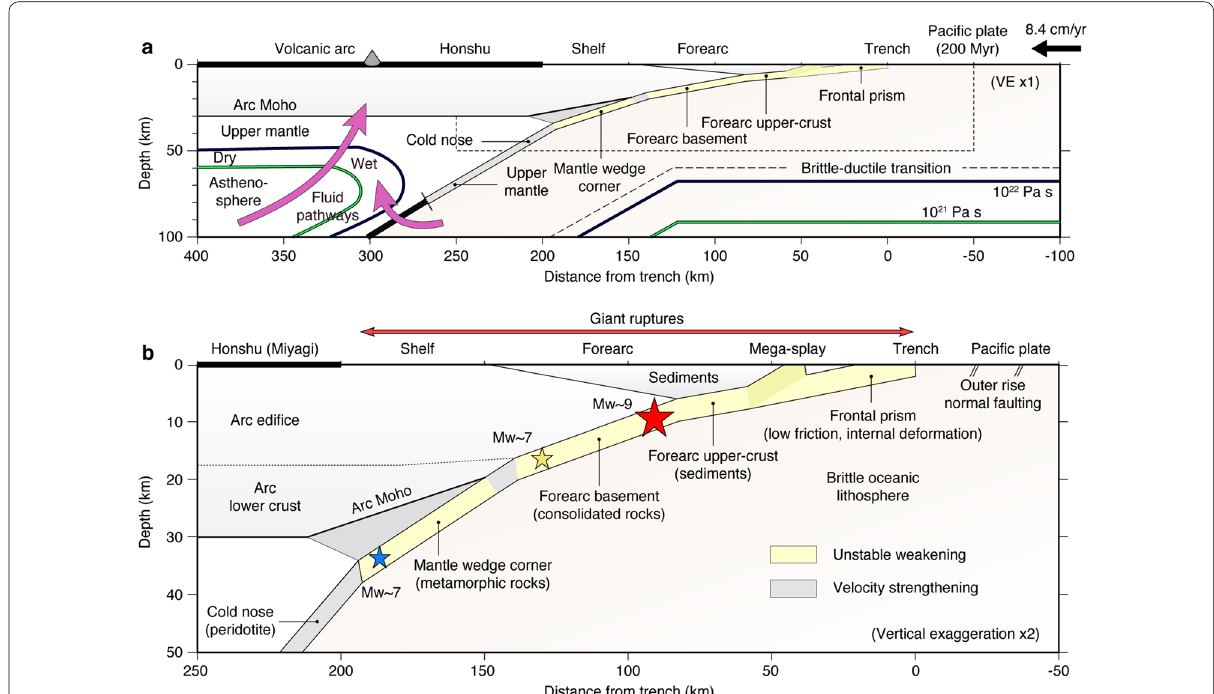
Fig. 9 Conceptual rheological model of the Japan trench at Miyagi. a The down-going Pacific slab intersects different terranes of the Japanese arc at various dip angles, introducing rheological and morphological gradients that shape the seismic super-cycle. The megathrust occupies the brittle regime of the plate interface, stopping down-dip at the brittle–ductile transition. In the mantle wedge, the coupling between the two plates is permanent, entraining corner flow below the volcanic arc. Fluids enter the mantle wedge underneath Honshu from the Pacific lithosphere and the Sea of Japan asthenosphere. b The megathrust is segmented into the weak frontal prism and the forearc upper crust, the forearc basement, the mantle-wedge corner, cold nose, and upper mantle. The segments are named after the hanging wall block that they underlie. The mega-splay fault delineates the active frontal prism. Large Mw ∼ 7 earthquakes are mostly confined in a single segment, with rupture nucleation close to structural boundaries. Giant Mw ∼ 9 ruptures break the entire offshore section, reaching the trench. Megathrust segments in the upper mantle exhibit stable creep. The cross-section area in b ) is shown as a dashed box in the top